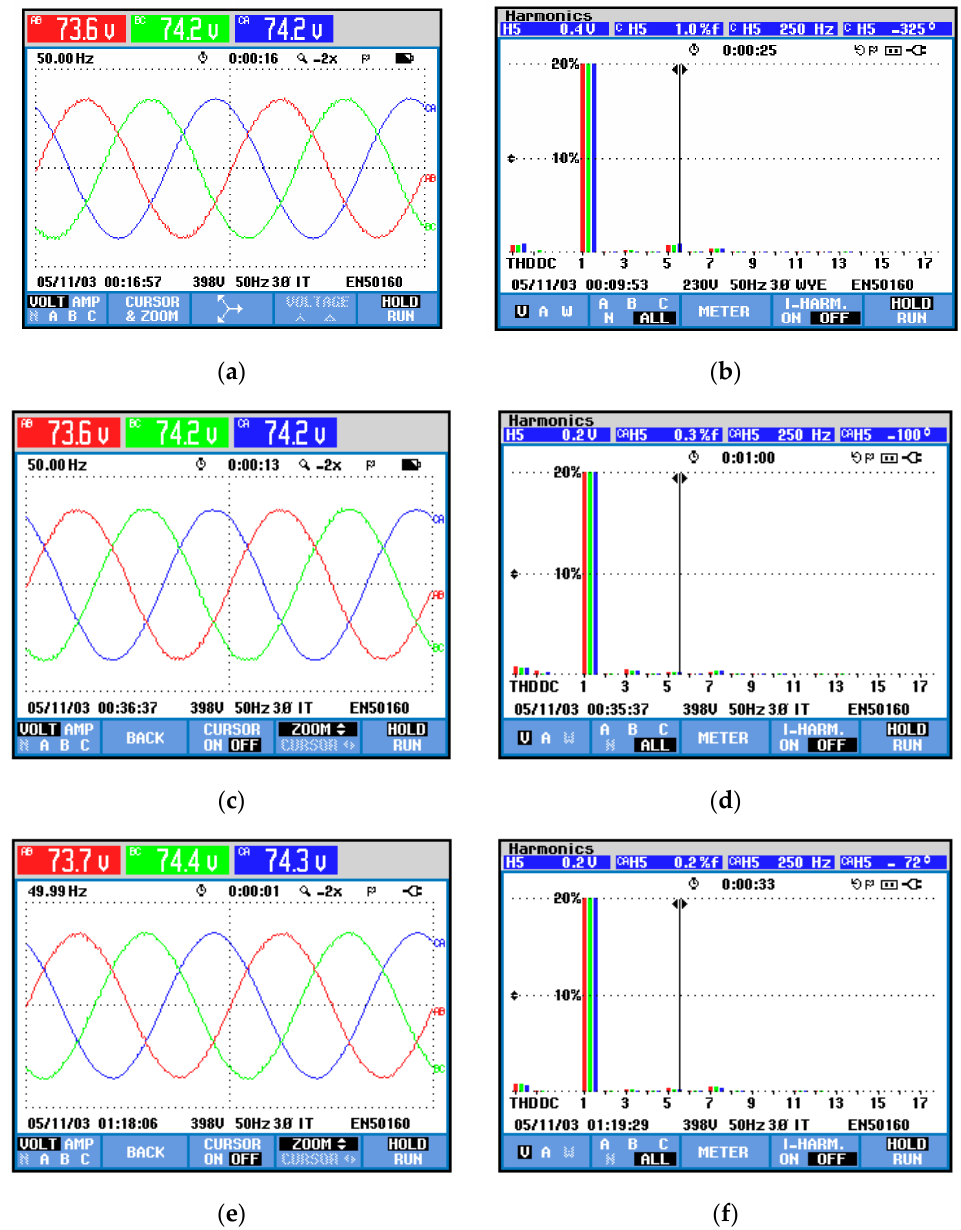
Figure 10. The experimental output voltage. ( a ) The output line voltage waveform without compensation; ( b ) The FFT magnitude of 5th order harmonic voltage without compensation; ( c ) The output line voltage waveform with the conventional algorithm; ( d ) The FFT magnitude of 5th order harmonic voltage with the conventional algorithm; ( e ) The output line voltage waveform with the proposed algorithm; ( f ) The magnitude of 5th order harmonic voltage with the proposed algorithm.